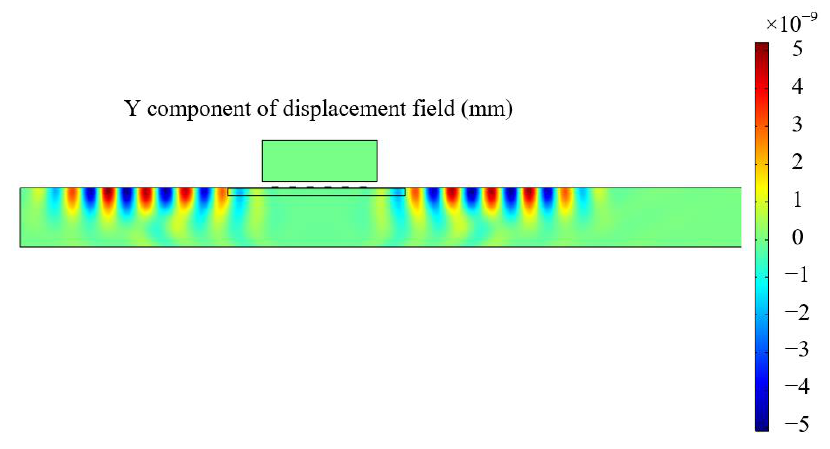
Figure 15. Y -direction component of surface wave (out-plane displacement).